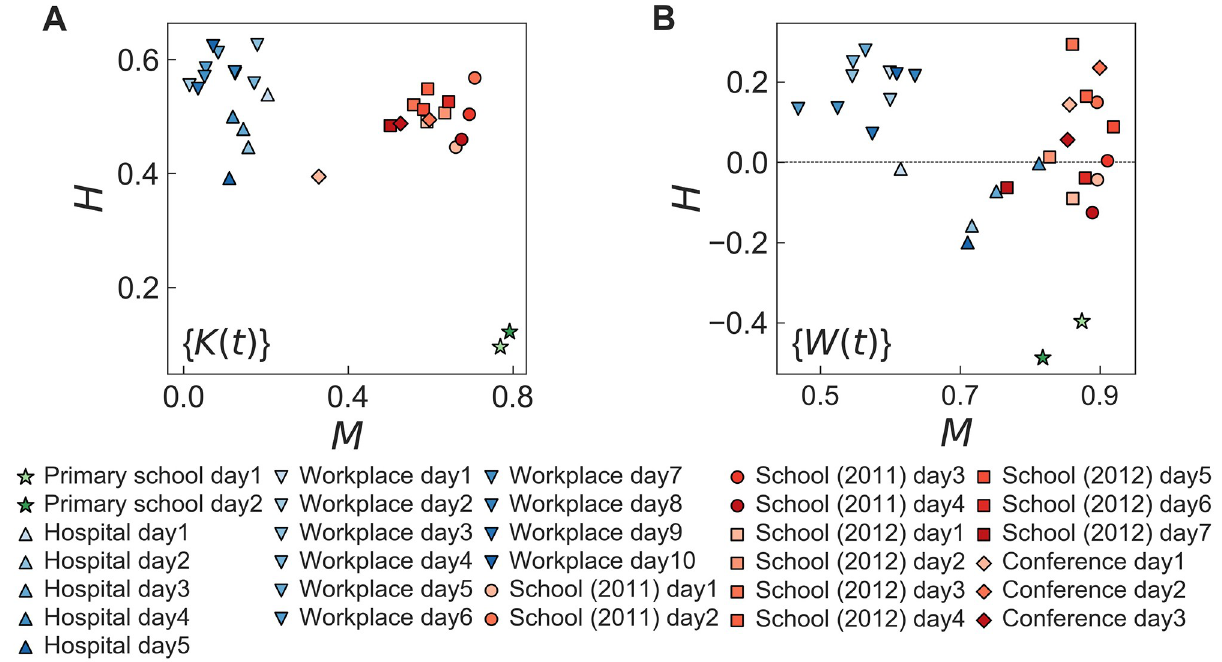
Fig 5. Scatter plot of values of H and M for empirical datasets. H in Eq (3) and M in Eq (4) in the ( M , H )-space for time series (A) { K ( t )} and (B) { W ( t )} are presented using the same datasets analyzed in Fig 4.